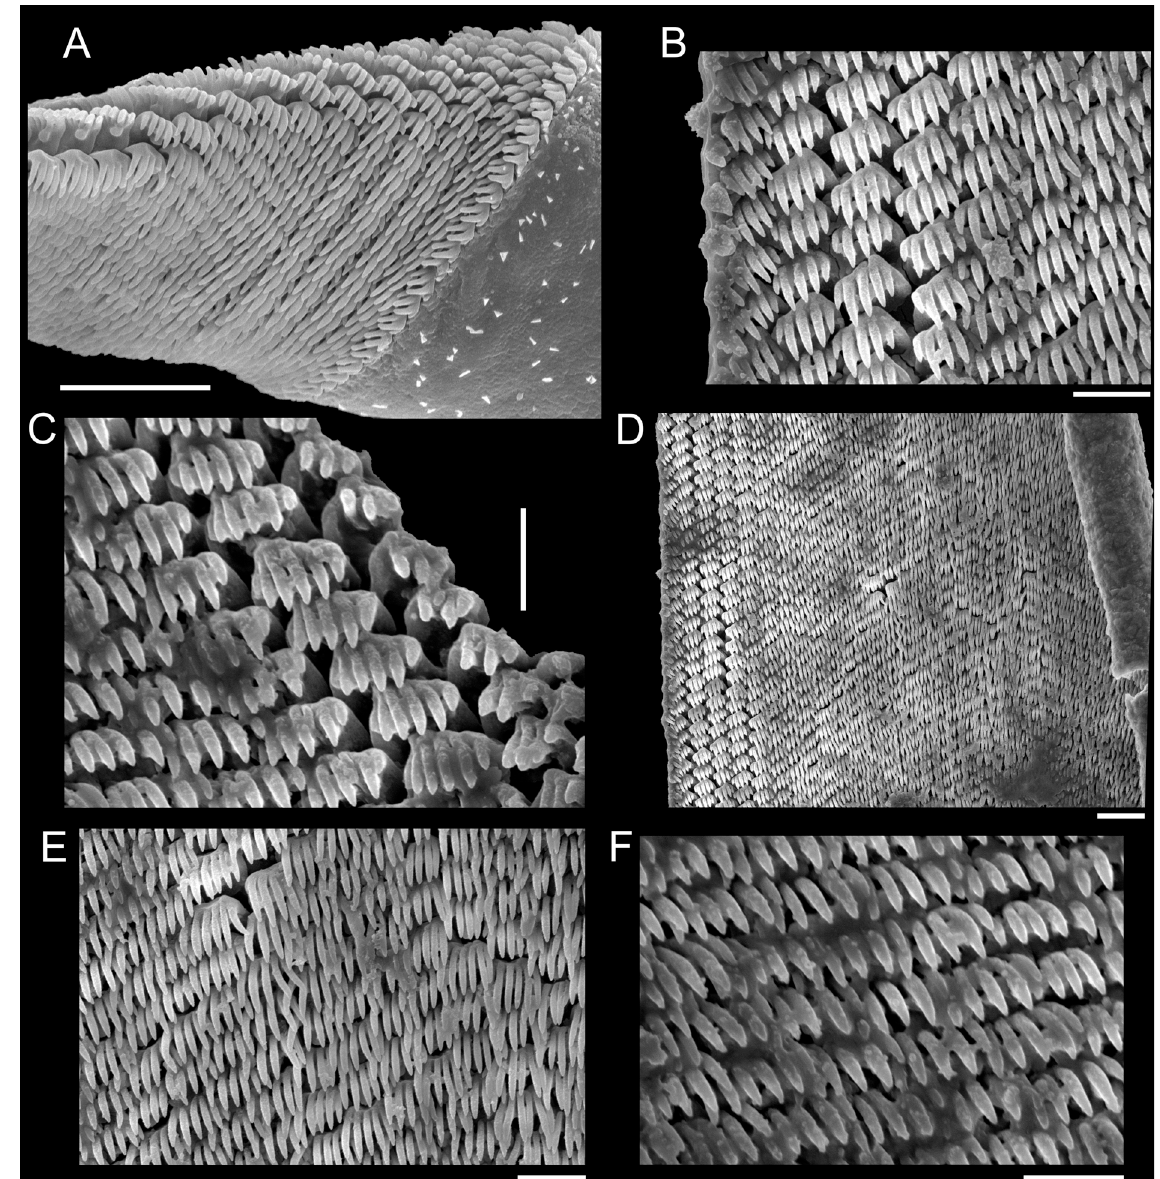
Fig. 17. Monophorus olivaceus (Dall, 1889), radula. A . MNRJ 35075. B–F . MNRJ 34240. Scale bars: A, D = 10 µm; B–C, E–F = 5